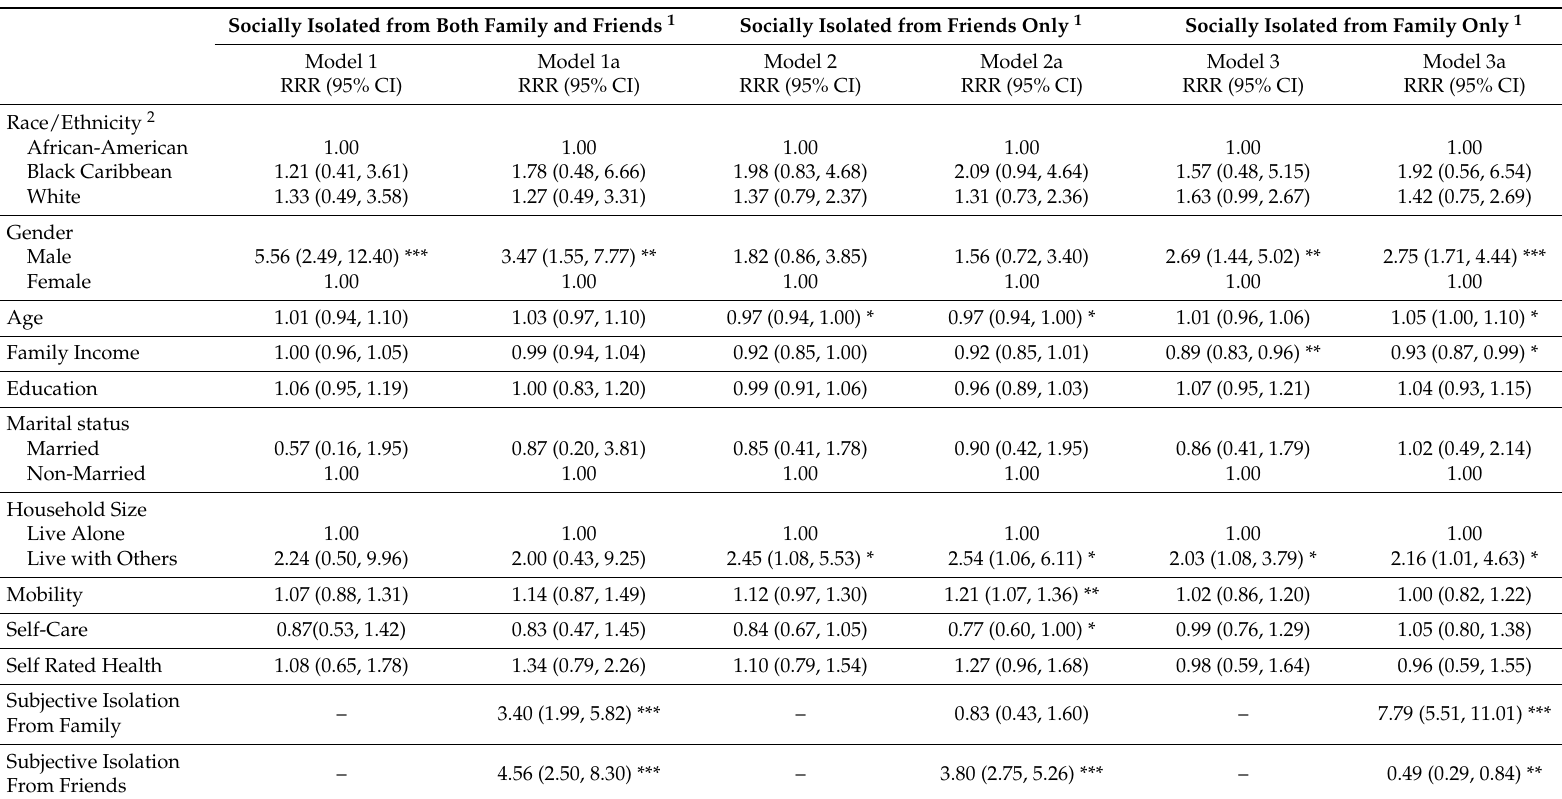
Table 2. Weighted Multinomial Logistic Regressions of Objective Social Isolation Among Older Adults ( n = 1321) in the National Survey of American Life (NSAL;